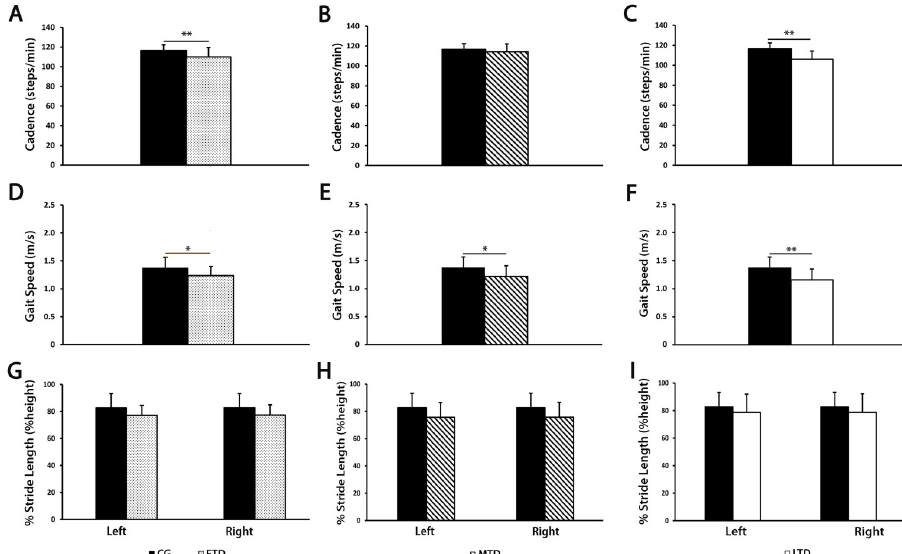
Fig 4. Cadence (panels A-C), gait speed (panels D-F) and percentage of stride length (% Stride Length, panels G-I) for healthy controls (CG, n = 24) and schizophrenia group (SG) divided by time from first hospitalization (early-term disease, ETD, n = 9; middle-term disease, MTD, n = 9; late-term disease, LTD, n = 9). T-tests were performed between CG and ETD, MTD, and LTD for cadence and gait speed; one-way ANOVA for comparisons between left and right percentage of stride length between CG and ETD, MTD, and LTD. Data were considered statistically significant if p - Value was less than 0.05. � p � 0.05, �� p < 0.01.